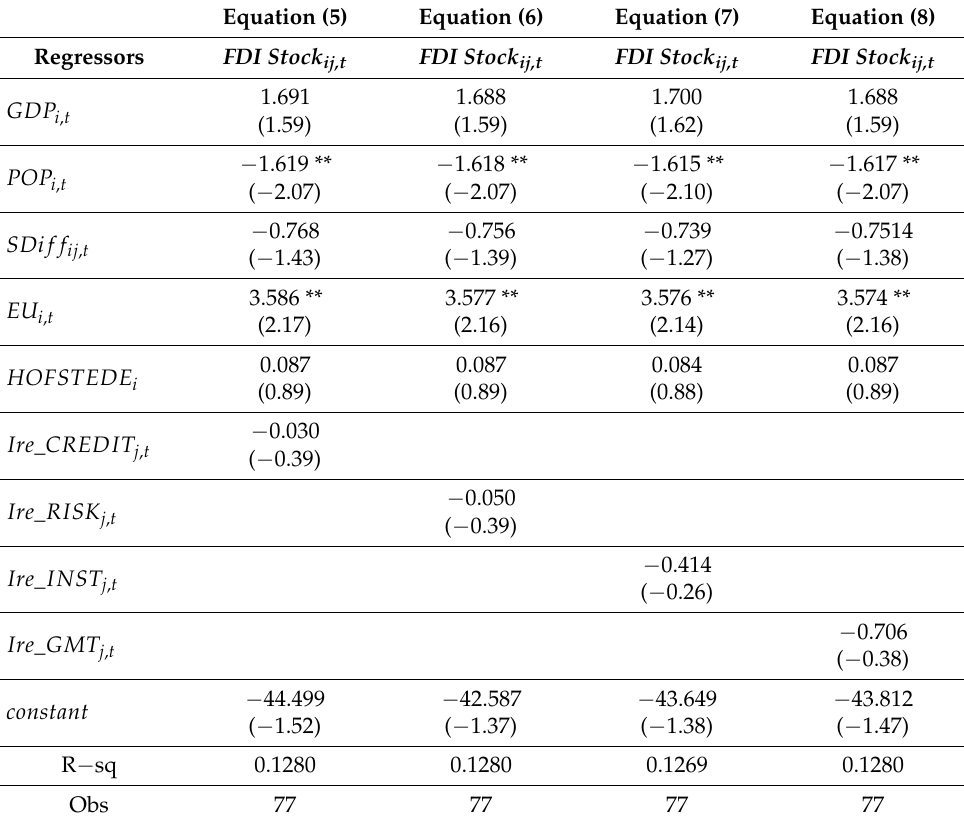
Table 6. 2008–2010